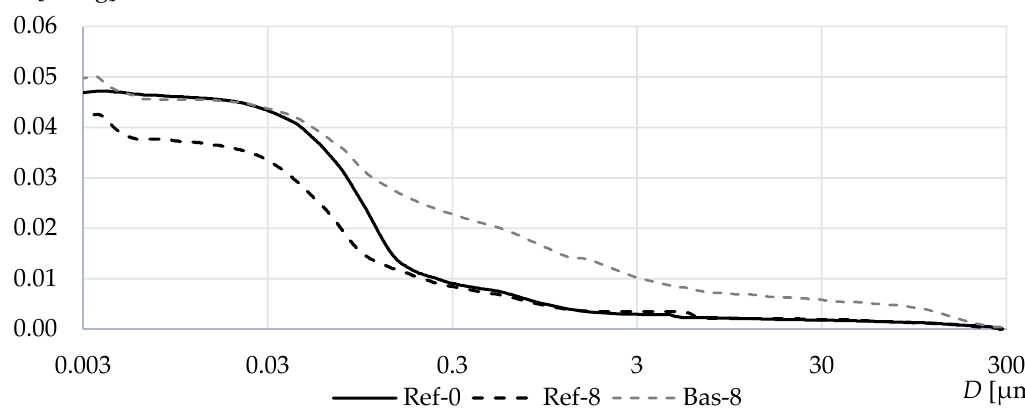
Figure 4. Cumulative normalized volume of the tested concretes measured by means of mercury porosimetry.